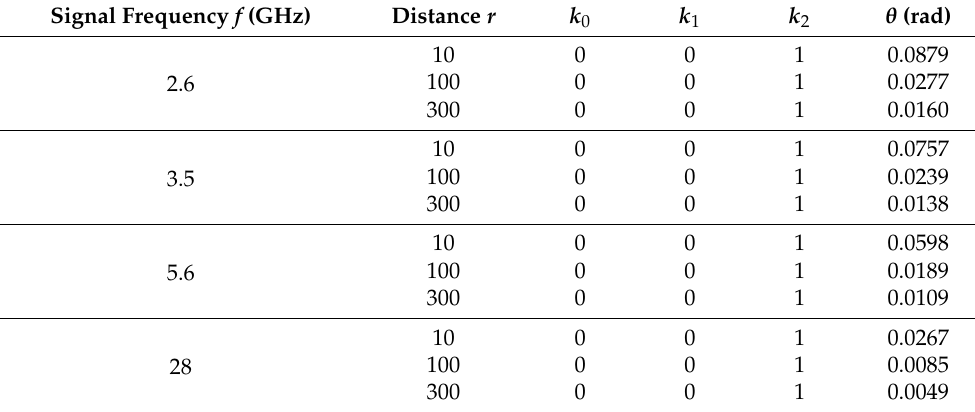
Table 1. Solution of the system equations.